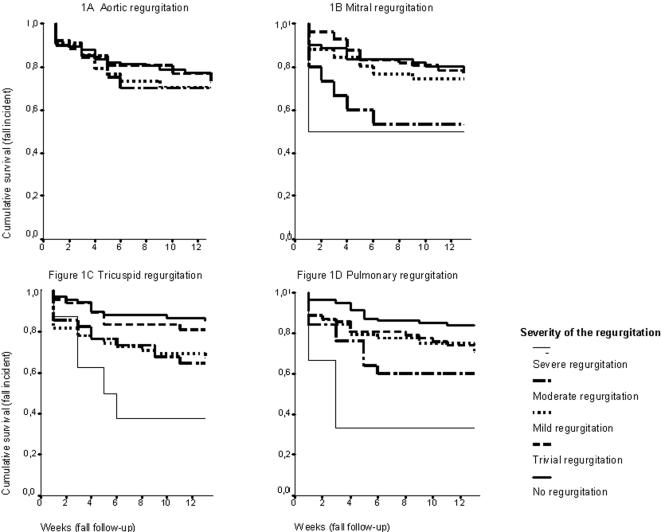
Kaplan-Meier Curve of Valve Regurgitation (Aortic, Mitral, Tricuspid and Pulmonary) According to Falls Incidence, Divided for Severity of the Regurgitation.